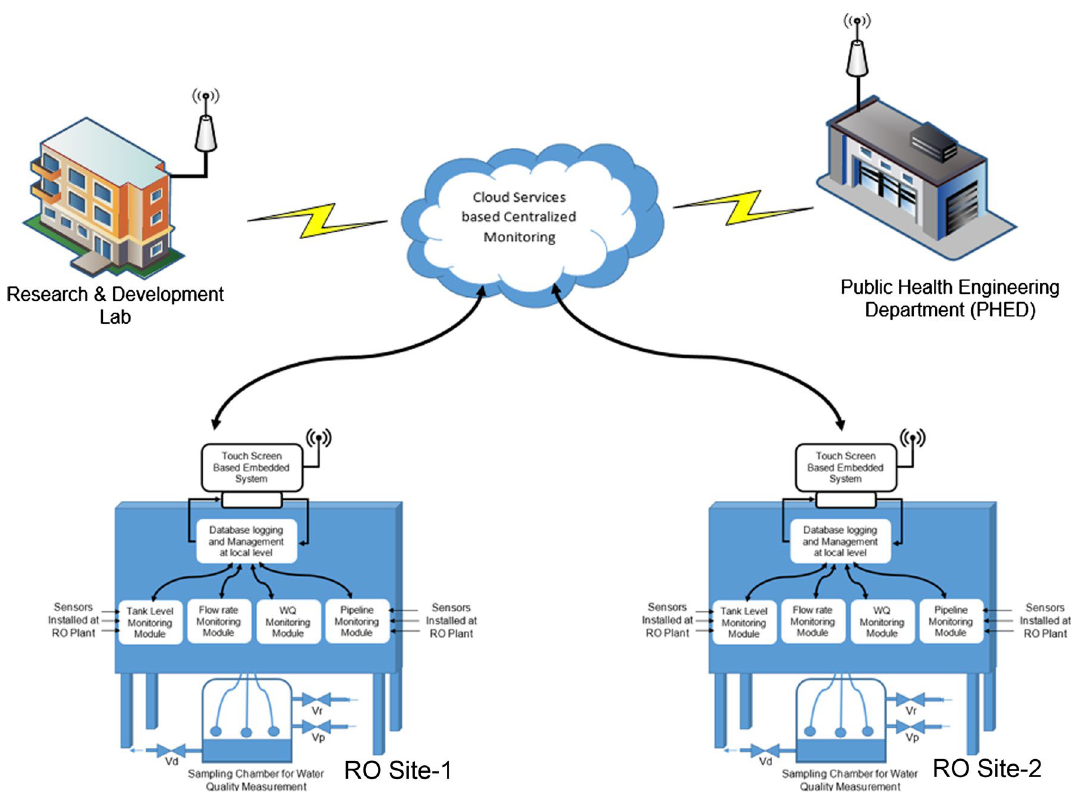
Fig. 1 Implemented RO plant status monitoring scheme for fault prediction and regular